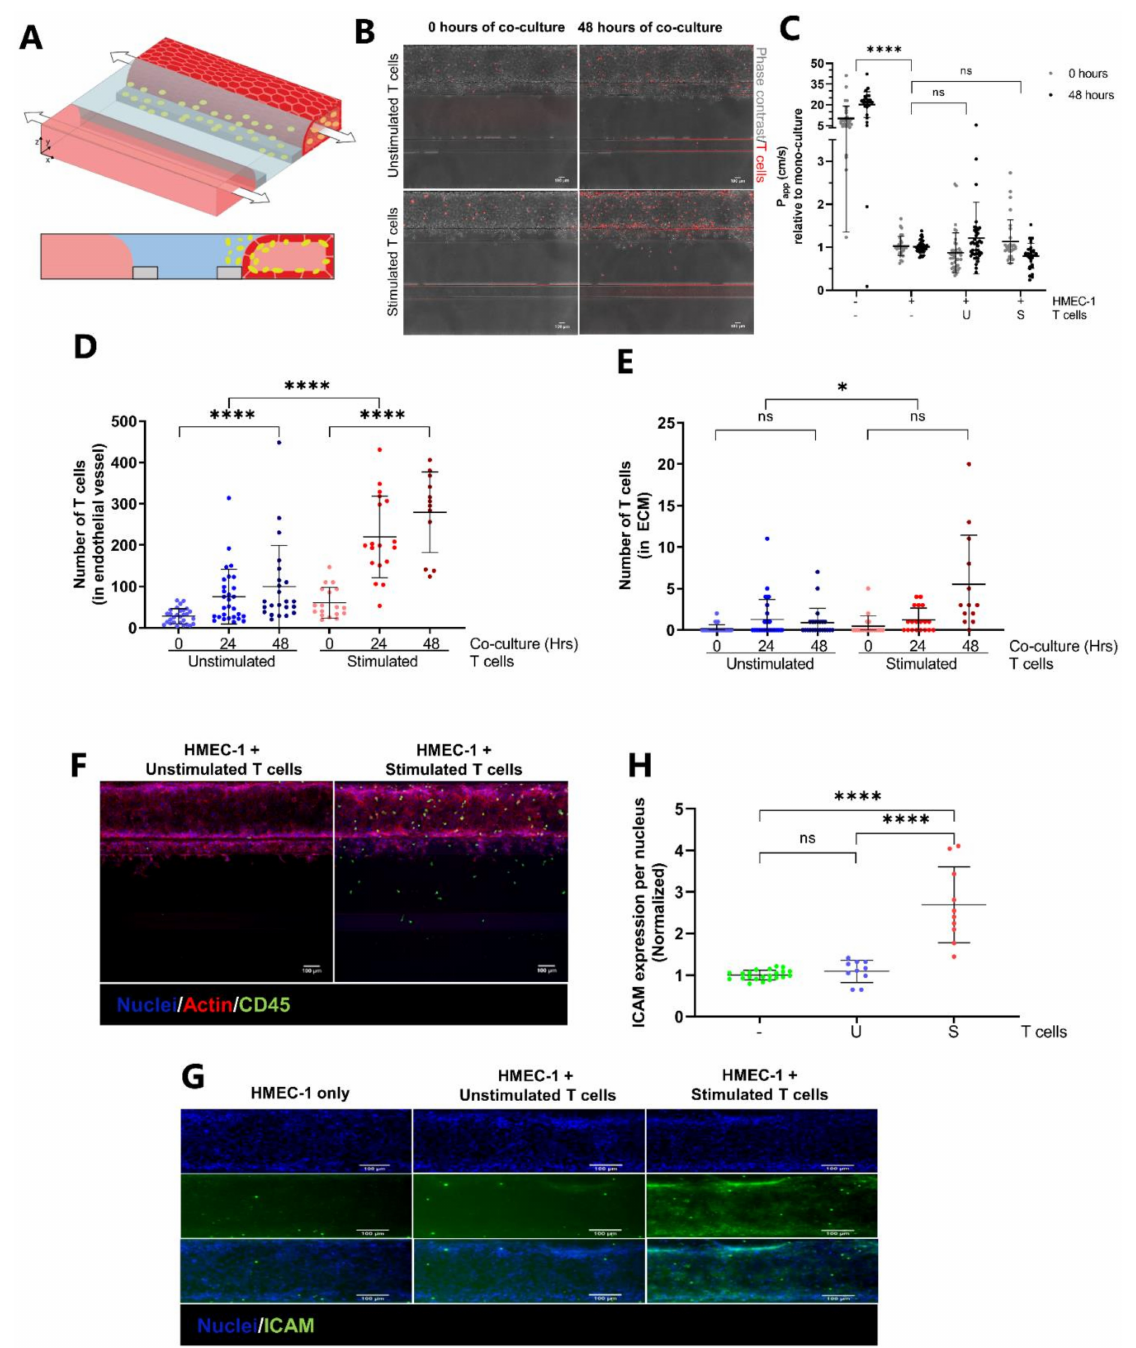
Figure 2. Characterization of a 3D co-culture comprising endothelial cells and T cells. ( A ) T cells (in yellow), unstimulated or stimulated with (CD3/CD28) beads, are added apically to the lumen of the HMEC-1 vessel. Upon perfusion, the T cells are able to undergo all steps of transendothelial migration (TEM); rolling, firm adhesion, crawling and migration across the endothelial vessel wall into the adjacent ECM. ( B ) Composite max intensity projections of live cultures consisting of HMEC-1 endothelial cells perfused with either unstimulated or stimulated fluorescently labelled T cells at the start and the end of 48 h co-culture. T cells (red, CellTracker Orange CMRA) reside inside the vessel and are able to extravasate into the adjacent ECM over time. ( C ) Barrier integrity of HMEC-1 vessels is not affected by co-culture with either unstimulated or stimulated T cells. Apparent permeability (Papp) values are normalized against Papp values of mono-cultured HMEC-1 vessels. Shown are mean ± SD, and data points represent individual chips ( N = 8–13, n = 2–5). Statistical analysis was performed on non-normalized data. Data were log transformed and analyzed using mixed-effects models. Statistical analyses indicated significant differences between chips containing HMEC-1 vessels and empty chips (**** p < 0.0001; ns = not significant)